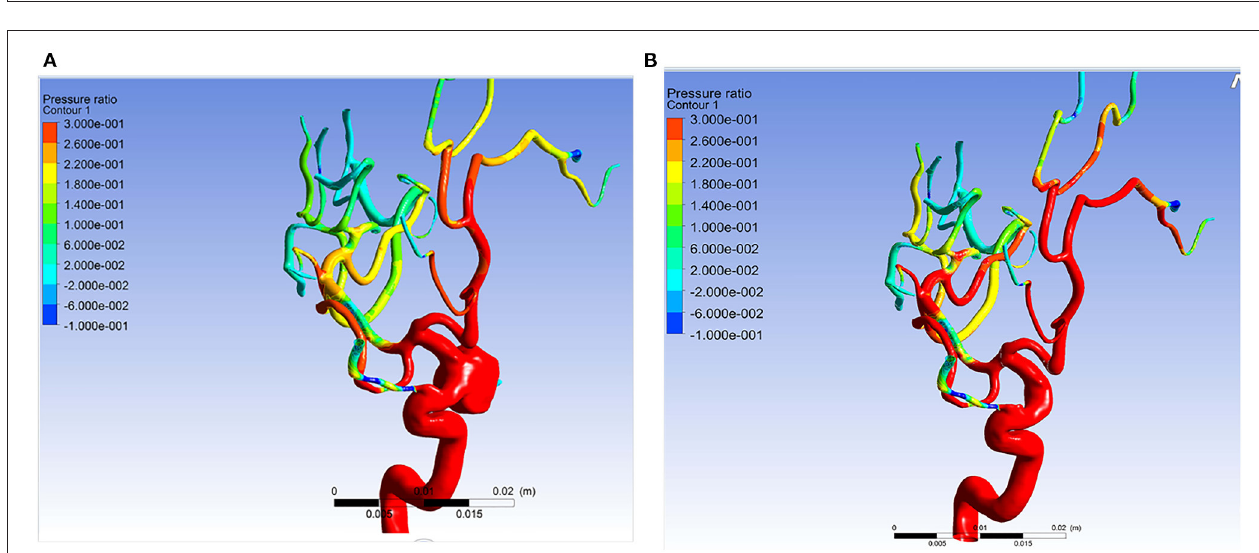
FIGURE 3 | Example of simulation results of patient 11. The pressure ratio in the arteries distal to aneurysm became higher after the aneurysm was obliterated. (A) The pressure ratio before obliteration of the aneurysm. (B) The pressure ratio after obliteration of the aneurysm.